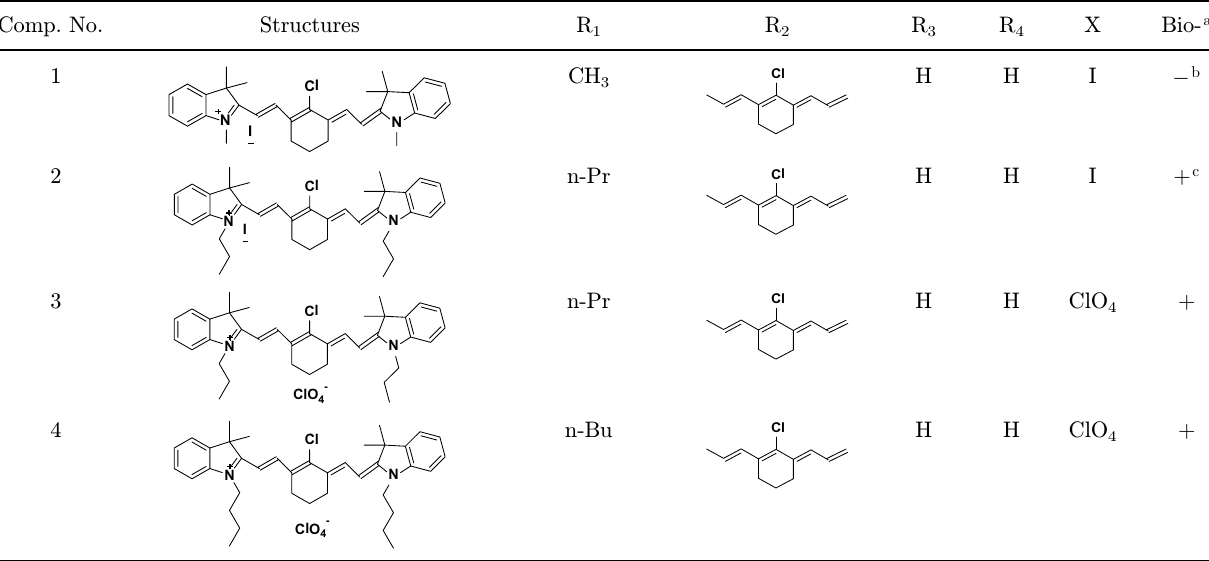
Table 1. Evaluation of various chemical structures of heptamethine indocyanine dyes on tumor-targeted bioactivity. Comp. No.